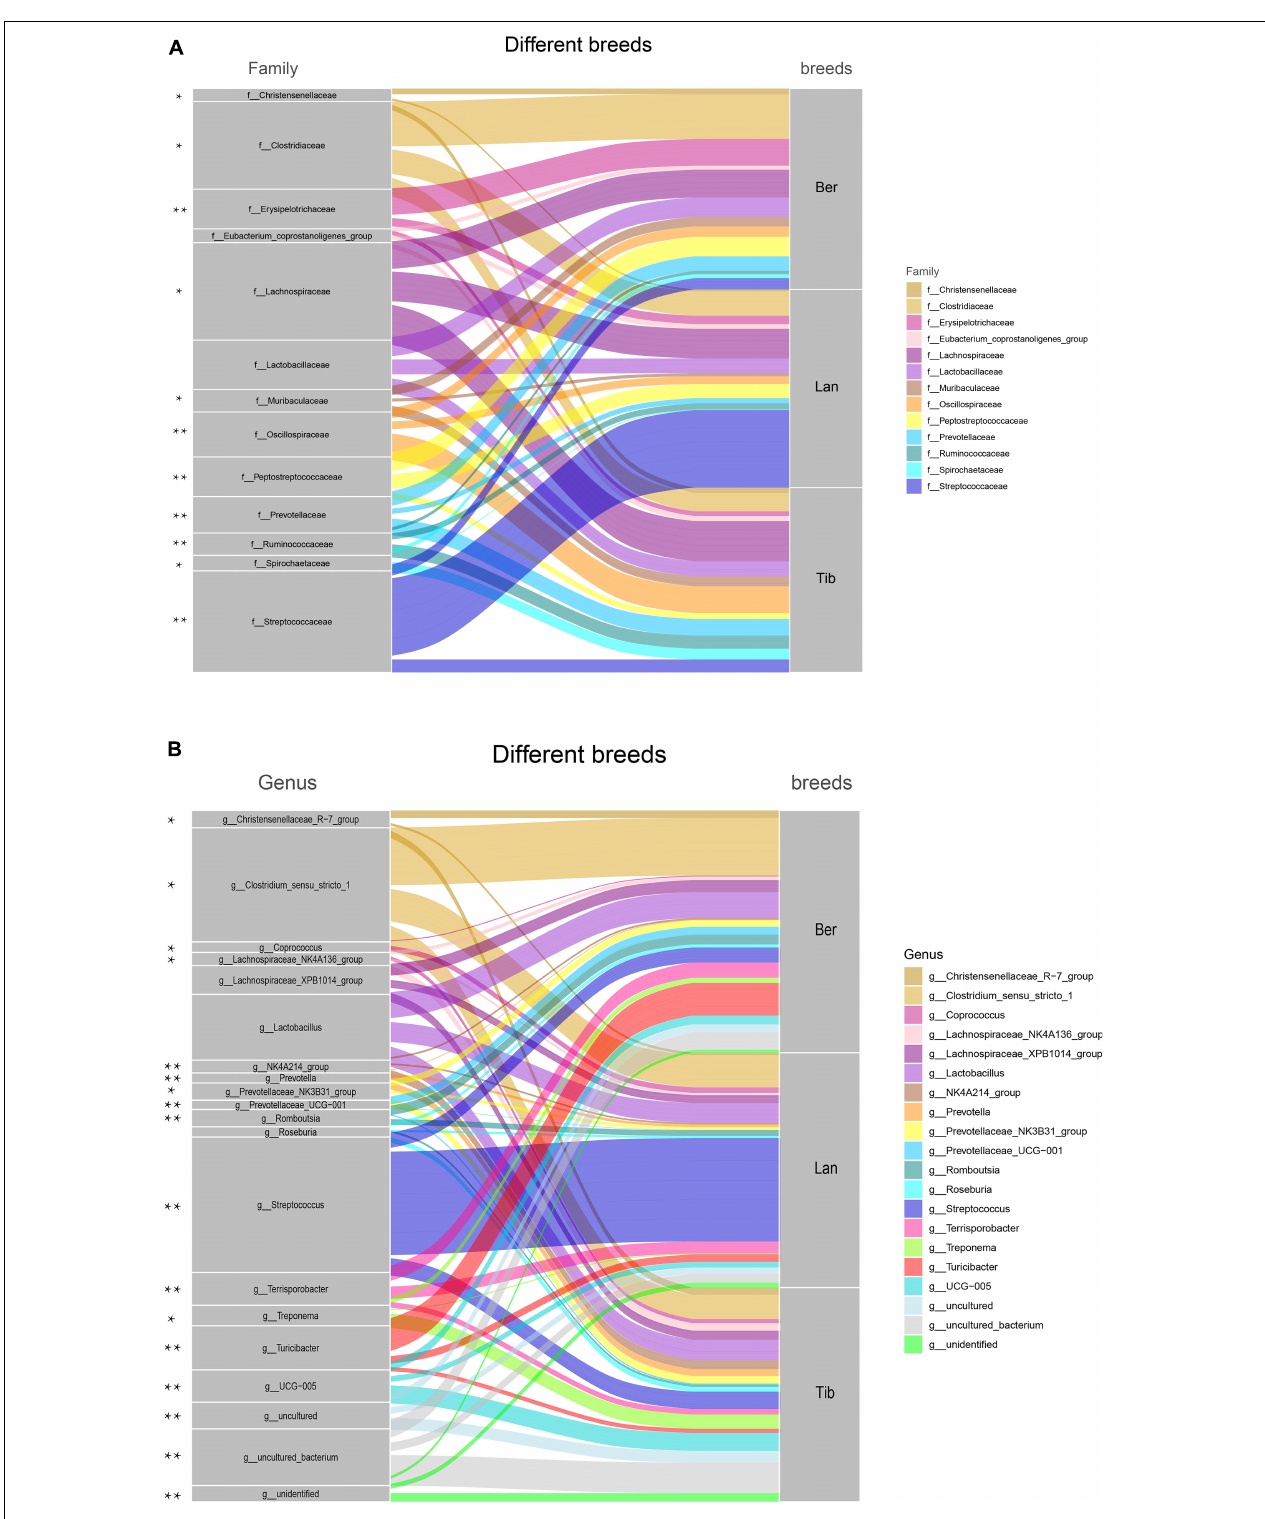
FIGURE 3 | Species composition in the fecal samples of Berkshire, Landrace, and Tibetan pigs. Top 13 dominant family (A) and top 20 dominant genus (B) were displayed. The color ribbons indicated the associations between families or genus and breeds, of which the colors represented as families or genus. The width of the ribbon reflected the scale of individual connections (the wider the ribbon, the stronger the association) it represented between the families or genus and the breeds. The statistical p -values were calculated by Kruskal–Wallis tests. * p < 0.05, ** p < 0.01.